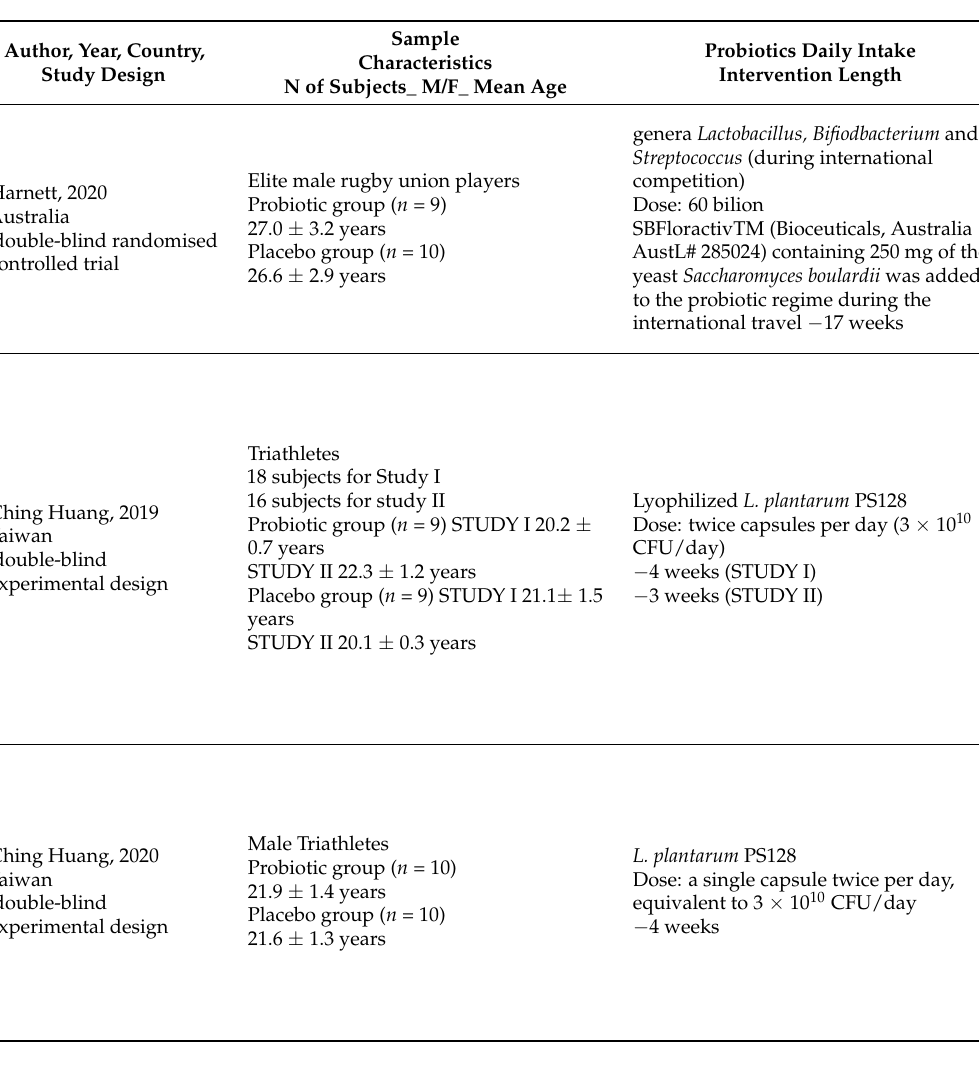
Table 2. Characteristics of the included